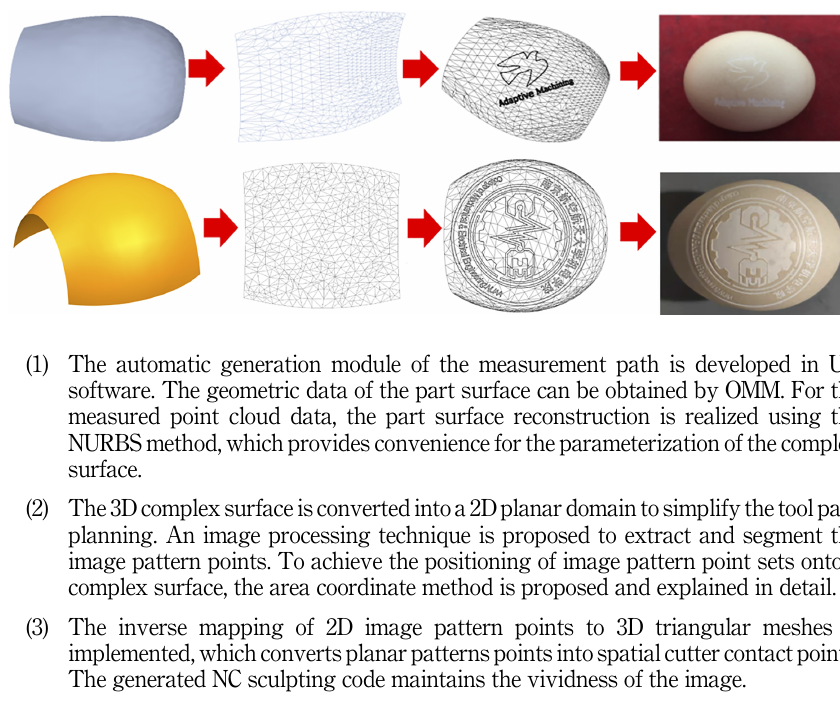
Figure 16. Pattern points and actual tool contact